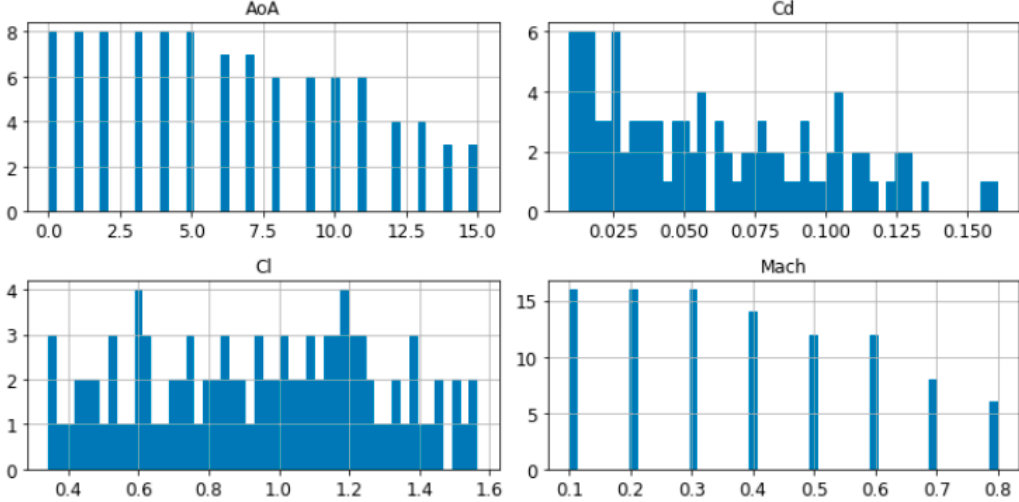
Figure 4. Histograms of the variables in the DPW database (X-axis shows the value of the parameter while Y-axis shows the number of occurrences of that value in the database).